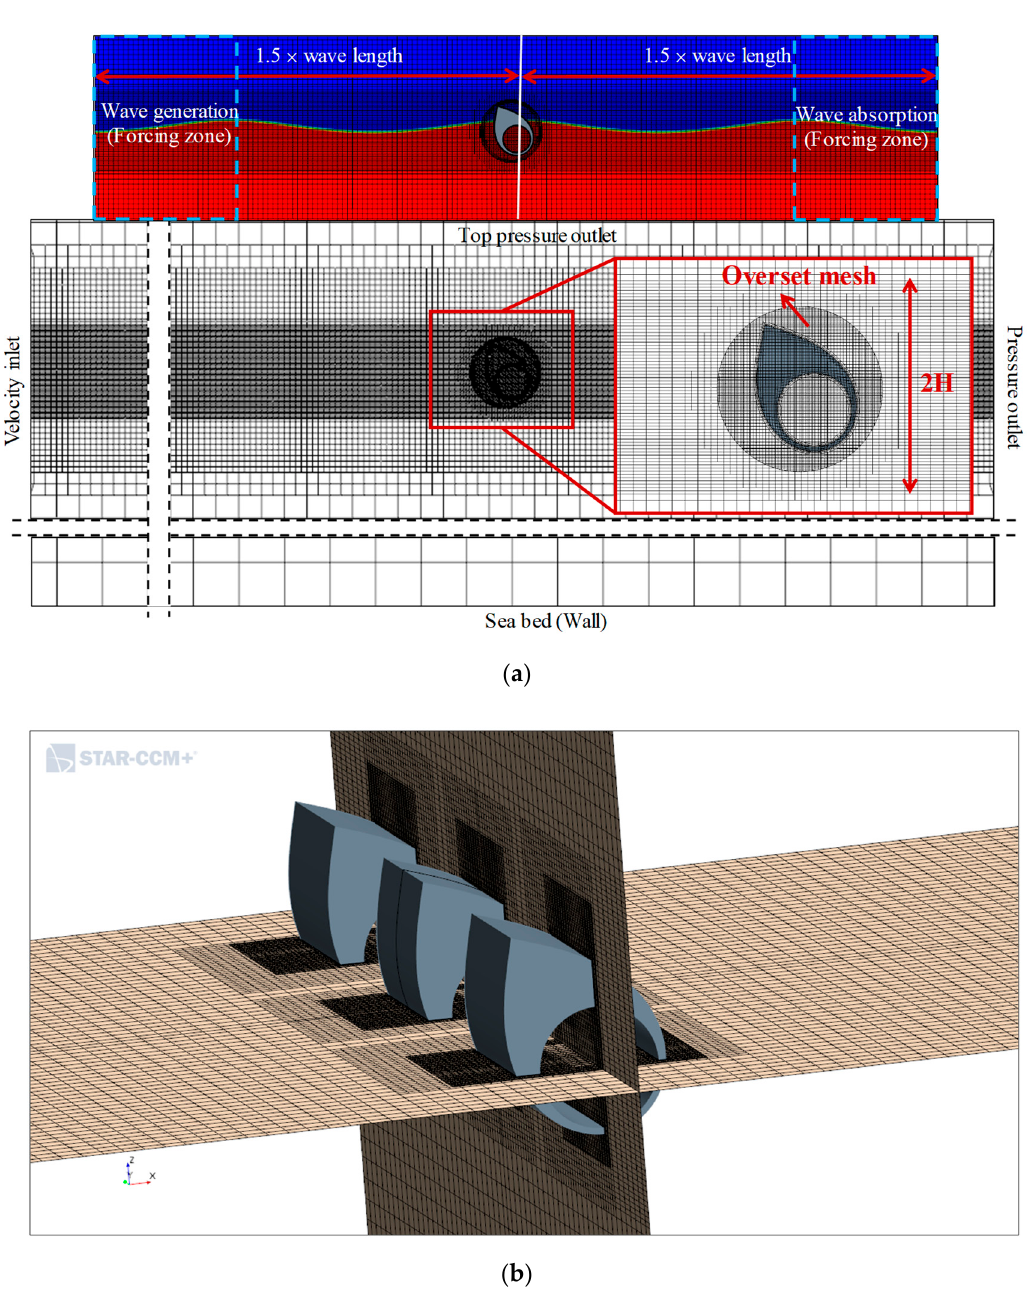
Figure 4. ( a ) Overview of computational mesh and associated boundary conditions ( b ) A close-up isometric view of the multiple WEC rotors.